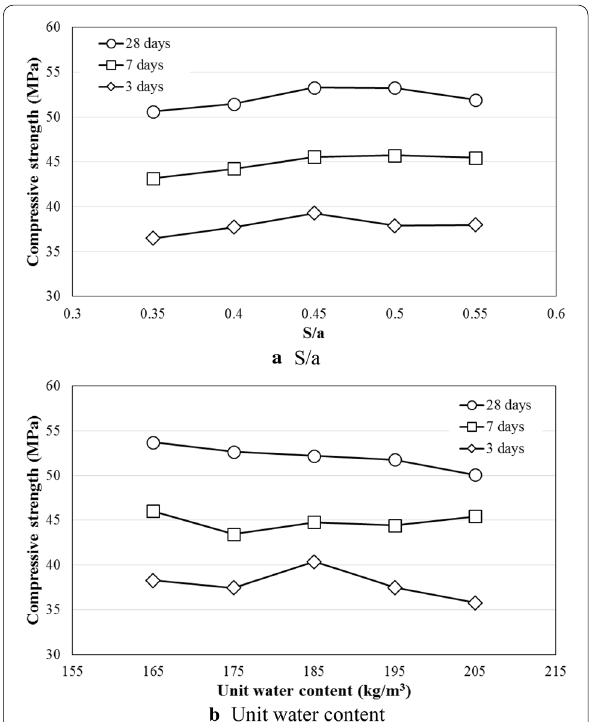
Fig. 16 Effects of S/a and unit water content on compressive strength of high‑strength concrete mixtures.